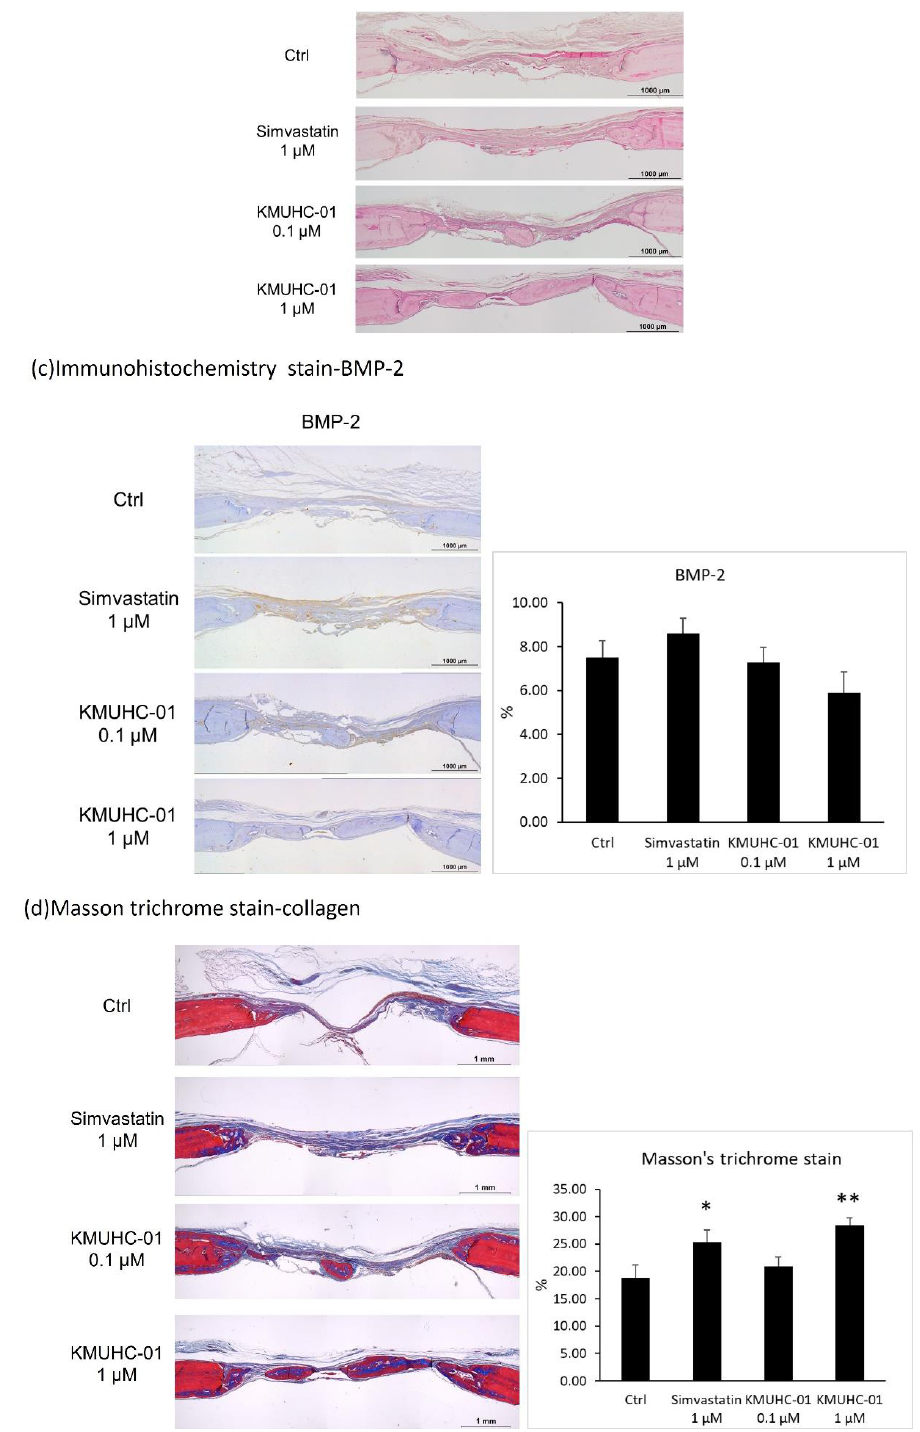
Figure 5. Rat calvarial bone defect treated with local simvastatin and KMUHC-01 injections. ( a ) The radiography study with micro-CT and the data of bone volume within the bone defect at 4 weeks postoperatively; ( b ) the representative sections of the histological study with hematoxylin and eosin (H&E) staining; ( c ) immunohistochemistry staining for BMP-2; and ( d ) Masson’s trichrome staining. (* p < 0.05; ** p < 0.01, comparison with control